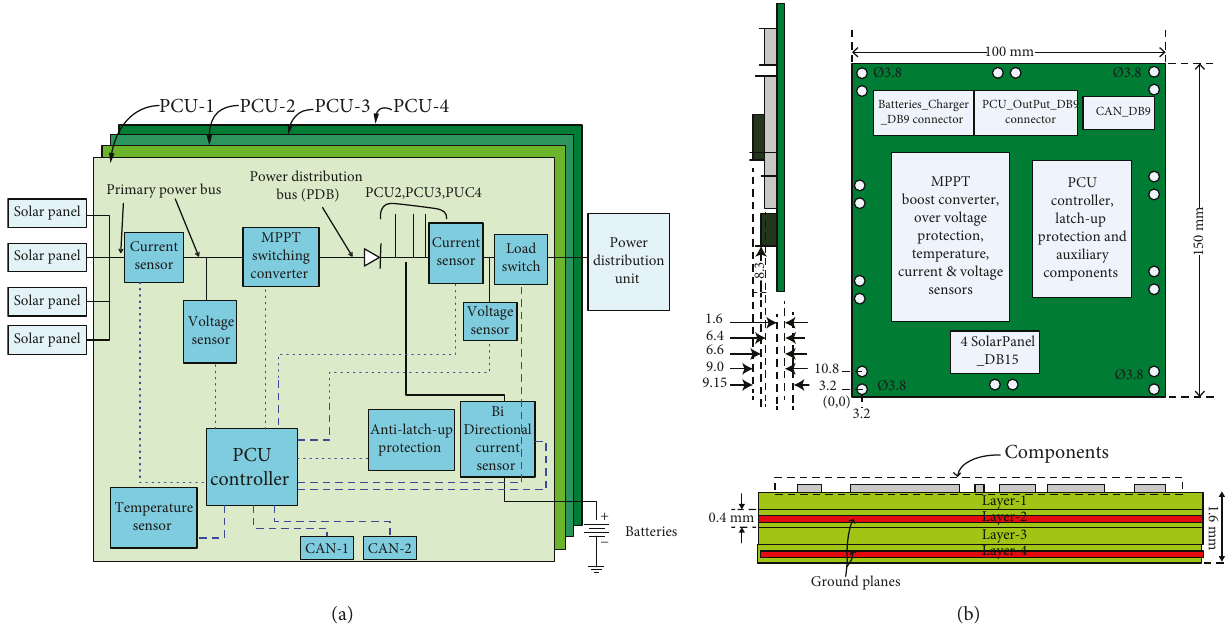
Figure 2: (a) PCM block diagram and (b) PCB